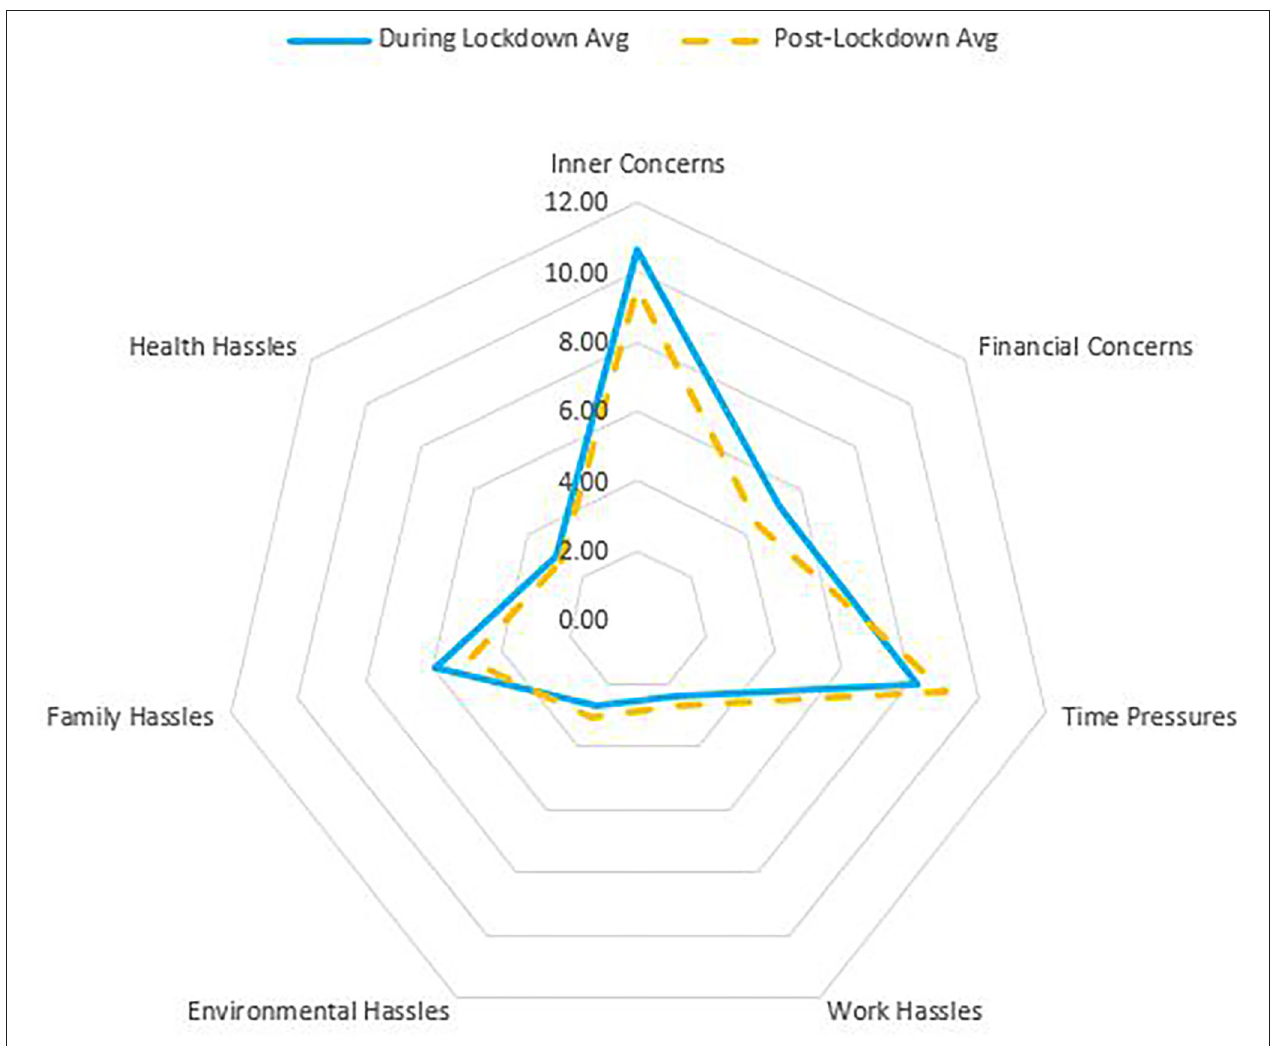
FIGURE 3 | Severity of the daily hassle categories experienced during- and post-lockdown.